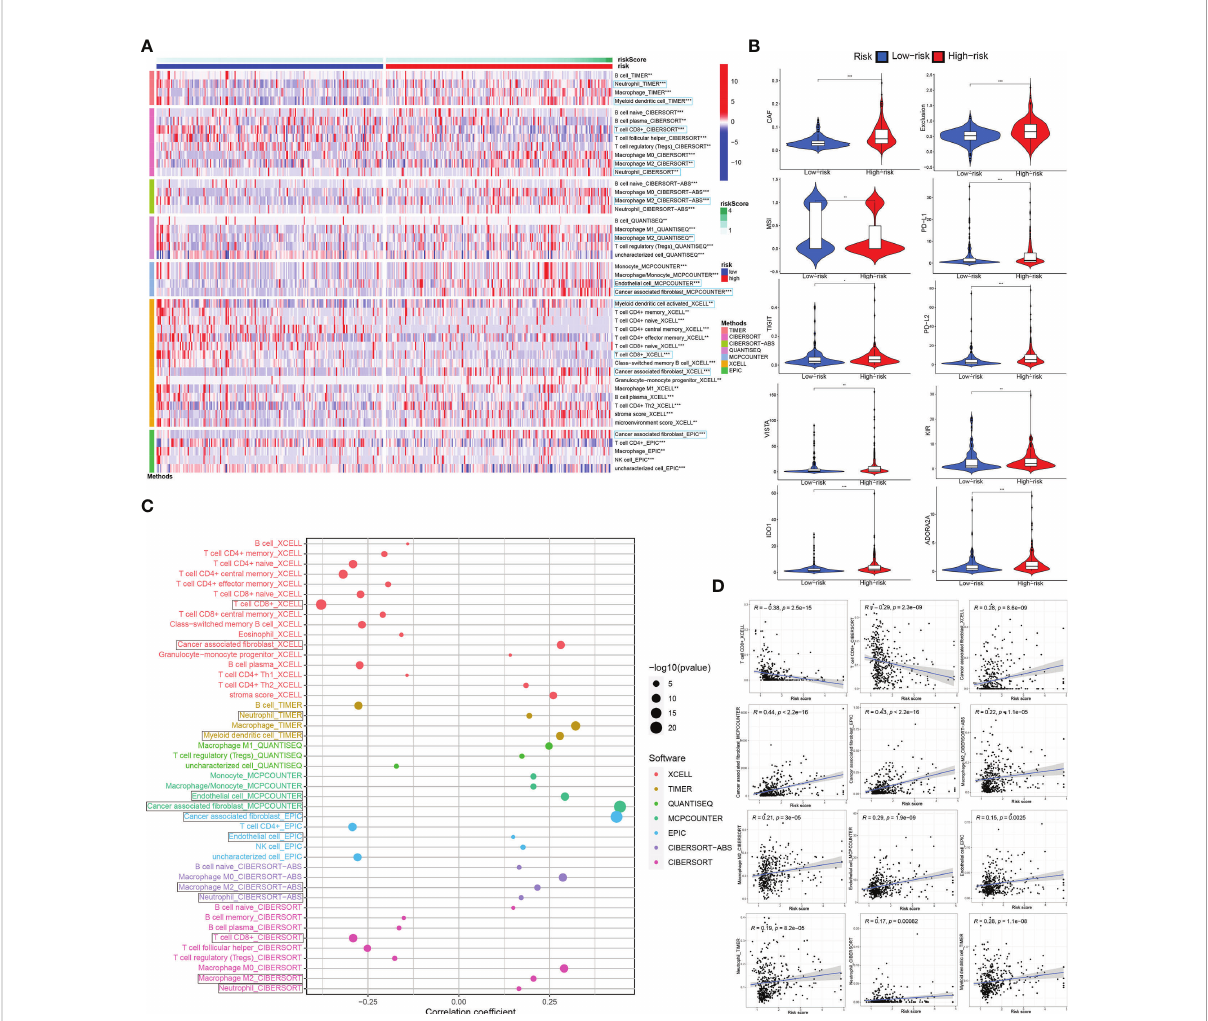
FIGURE 7 Associations between ceRNA-associated gene signature and immune-cell in fi ltration, immune checkpoint immunotherapies. (A) There were distinct differences in many immune cells in fi ltration between the high- and low-risk groups. (B) The TIDE algorithm analysis and the expression of partial immune checkpoint genes was used to predict the immune response to immune checkpoint therapy in BCa patients based on riskscore. (C, D) Correlation analysis between in fi ltrating immune cells abundance from 7 immune-in fi ltration algorithm and the riskscore. ceRNA, competing endogenous RNA; TIDE, tumor immune dysfunction and exclusion; BCa, bladder cancer. *P < 0.05, **P < 0.01 and ***P <